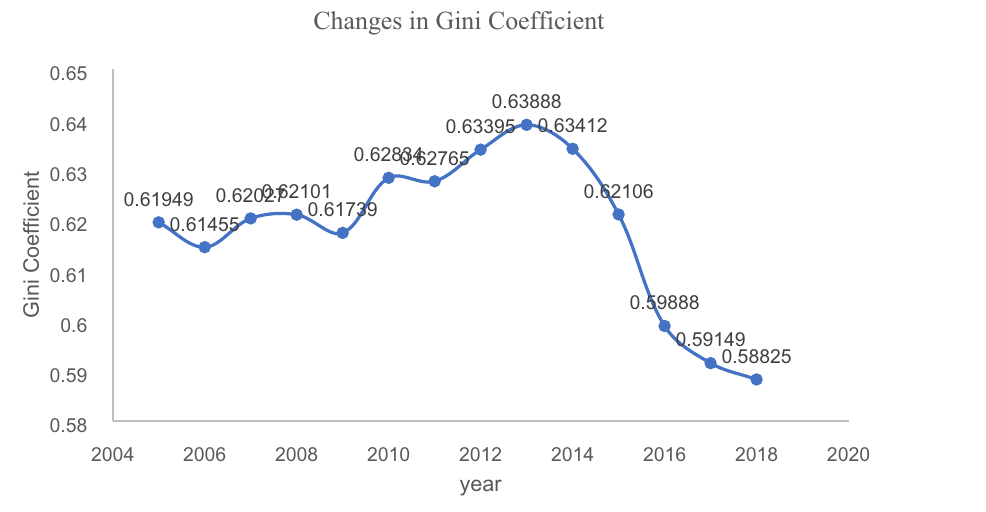
Figure 7. Changes in Gini Coefficient of population size in